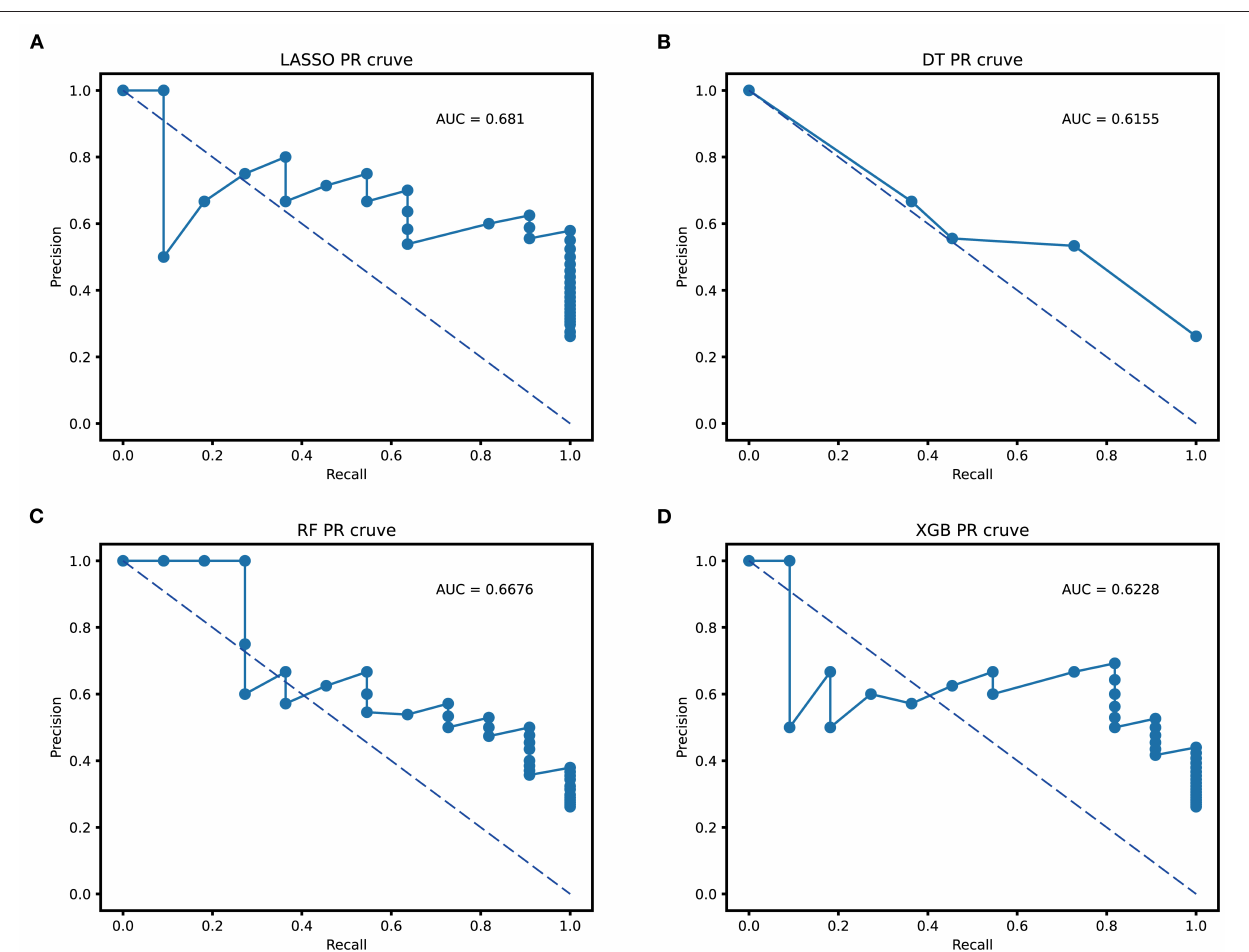
62 and 90% than tree-based models in external